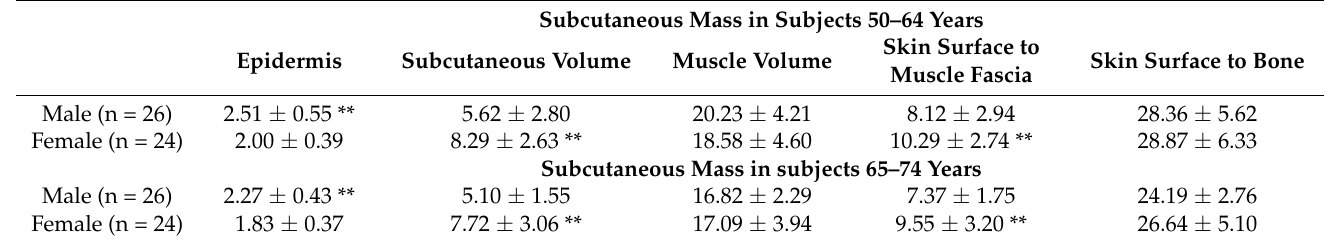
Table 4. Gender difference in subcutaneous mass.